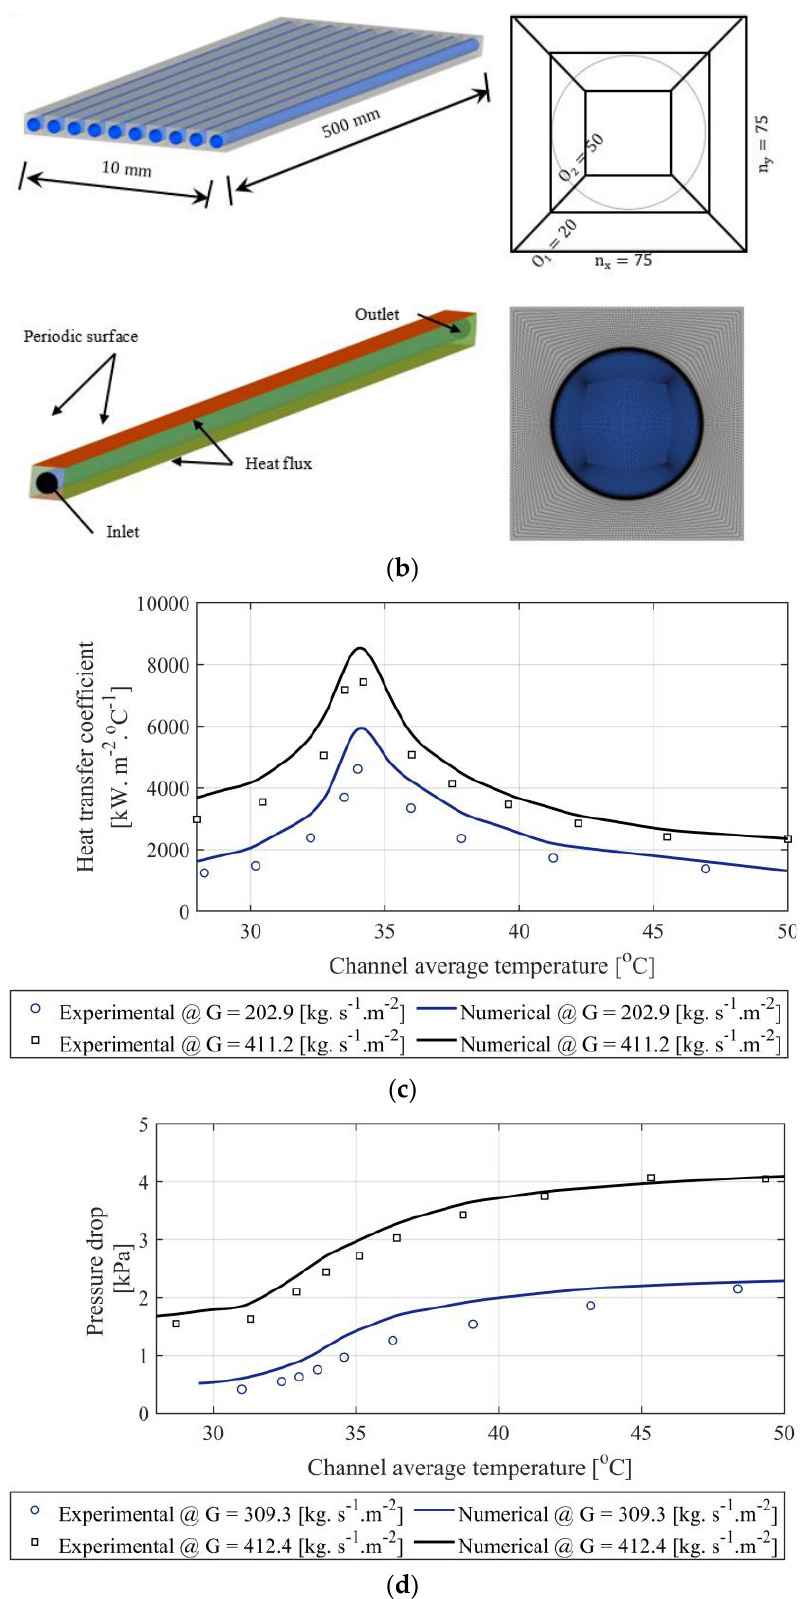
Figure 3. ( a ) Comparison of pressure drop values of the water of the current work and Saeed and Kim [42], ( b ) computational domain and mesh, ( c ) comparison of the heat transfer coefficients [3] ( d ) comparison of the pressure drop [3].